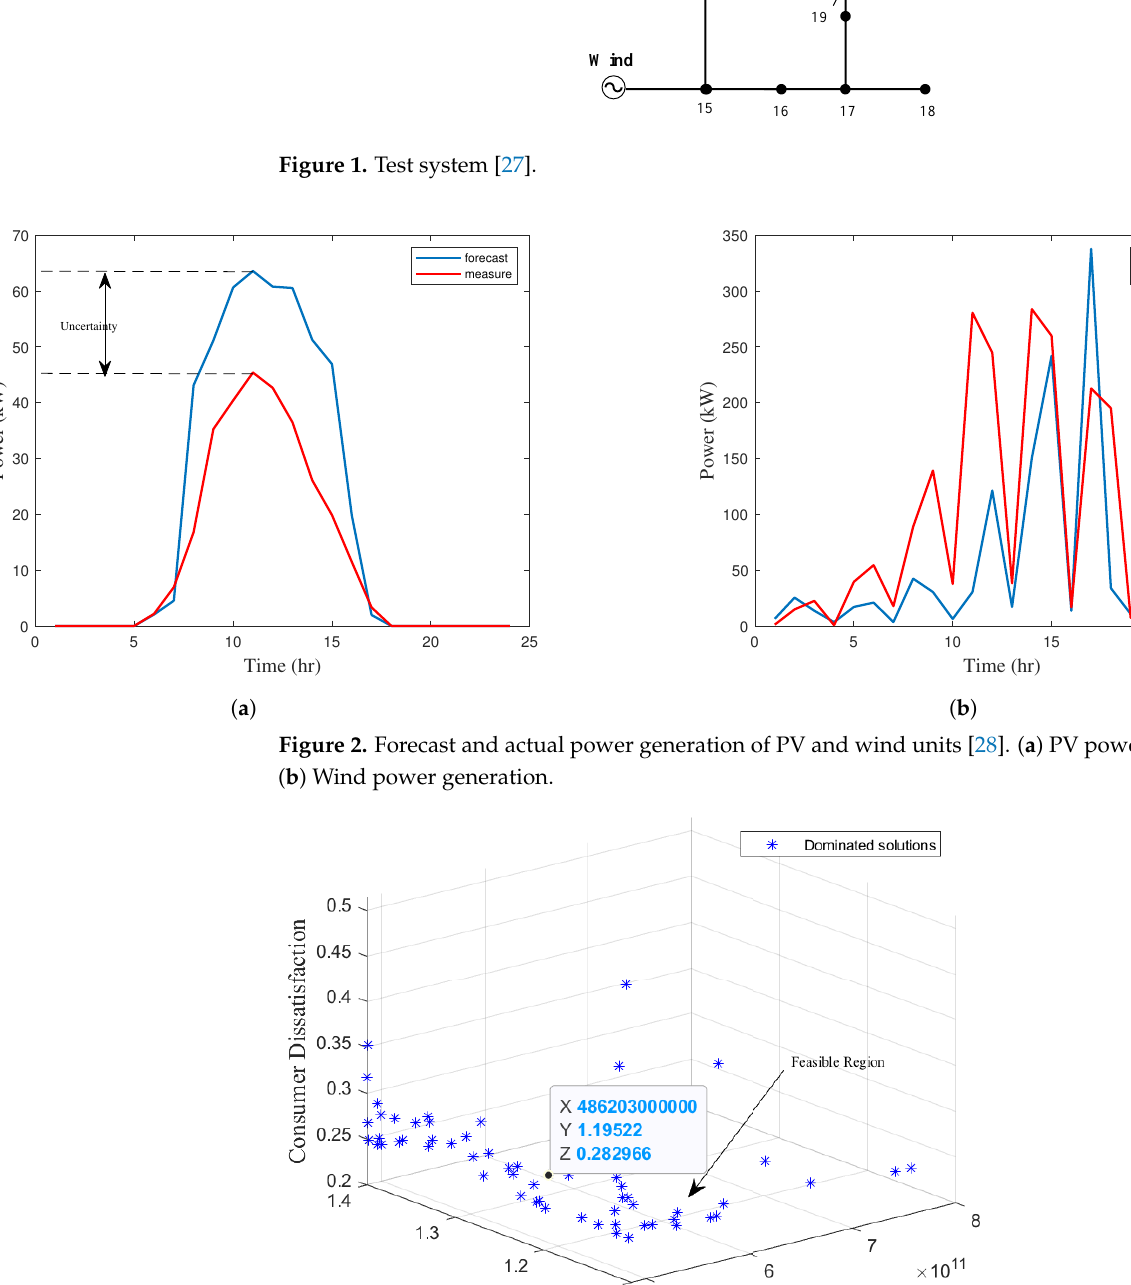
Figure 1. Test system [27].